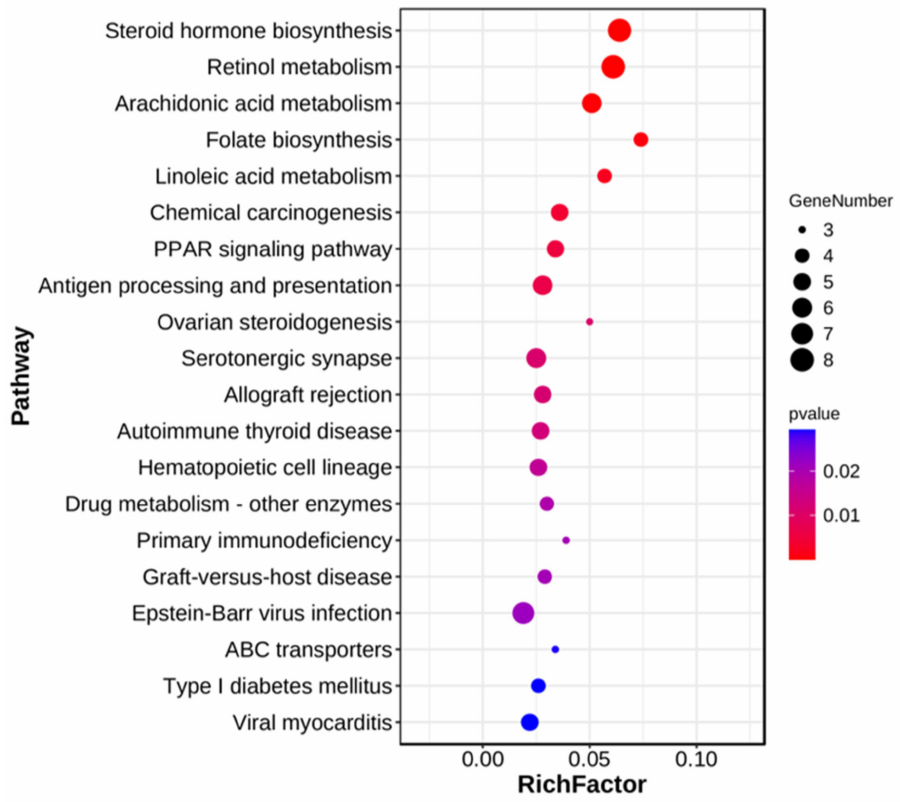
Figure 2. The top 20 KEGG pathways with the most significant enrichment of